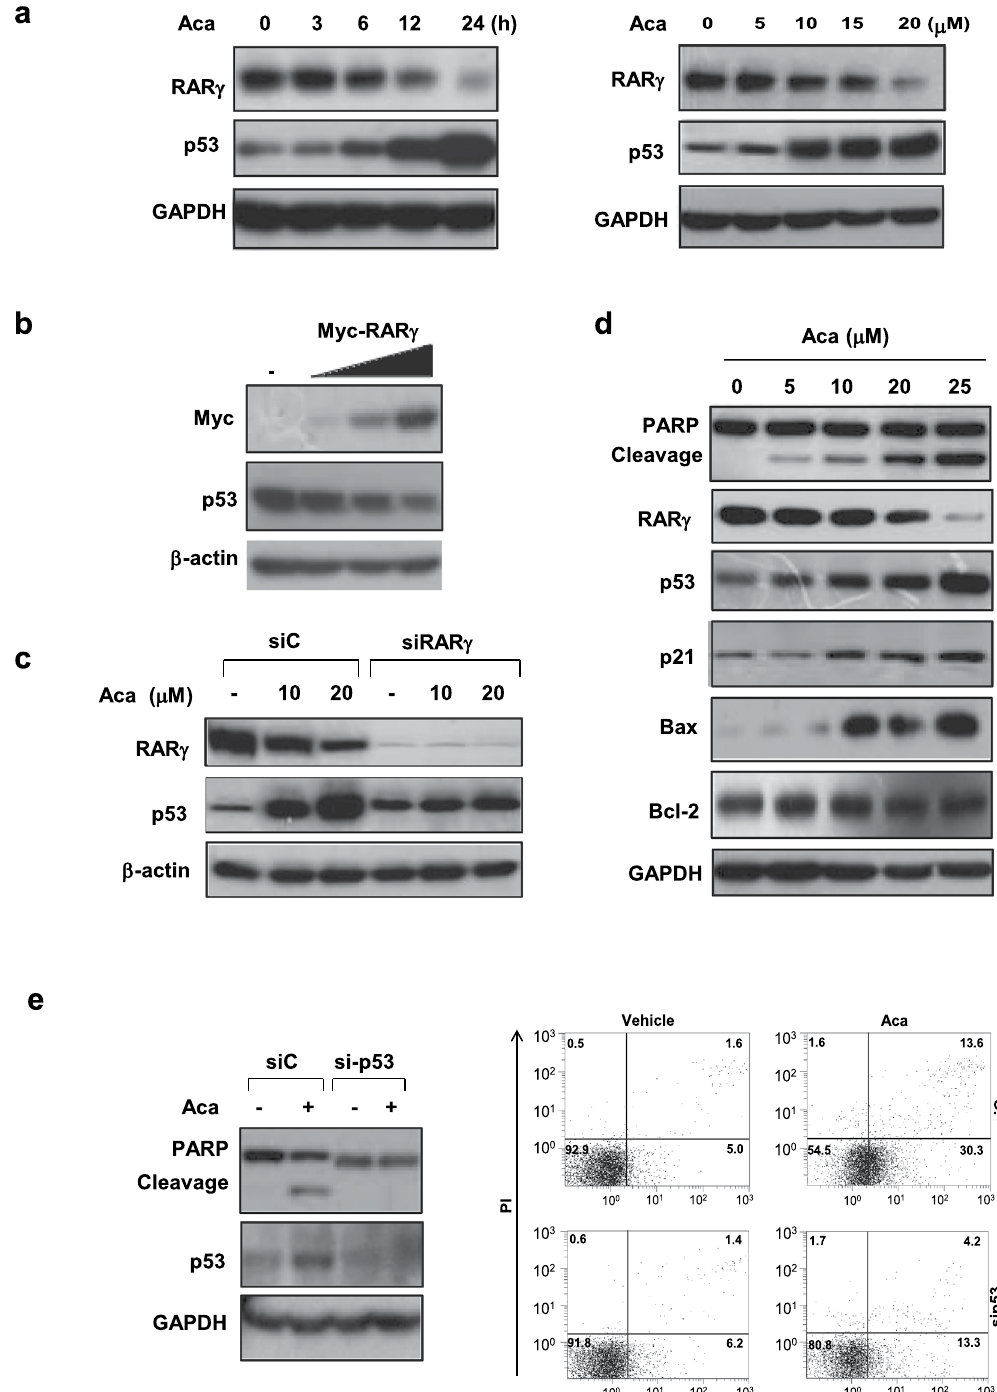
Figure 3. RAR γ is a negative regulator of p53. ( a ) HepG2 cells were treated with 15 μ M acacetin for different time scales, or with different concentrations of acacetin for 24 h. The effects of acacetin on RAR γ and p53 expression were demonstrated. ( b ) HepG2 cells transiently transfected with 10, 30 and 50 ng myc-RAR γ were cultured for 32 h. ( c ) HepG2/siRAR γ and HepG2/siC cells were treated with 10 μ M or 20 μ M acacetin for 24 h. The relationship between RAR γ and p53 proteins was analyzed. ( d ) HepG2 cells were treated with different concentrations of acacetin for 24 h. The effects of acacetin on PARP cleavage and the expression of RAR γ , p53, p21, Bax and Bcl-2 were determined. ( e ) HepG2 cells stably transfected with p53 siRNA (sip53) or scramble siRNA (siC) were treated with 15 μ M acacetin for 24 h. The role of p53 in the apoptotic effect of acacetin was determined by PARP cleavage (left) and Annexin V/PI staining (flow cytometry assays, right). The expression levels of all above proteins were essayed by Western blotting. β -actin or GAPDH was served as loading controls. All blots were cropped to remove irrelevant or empty